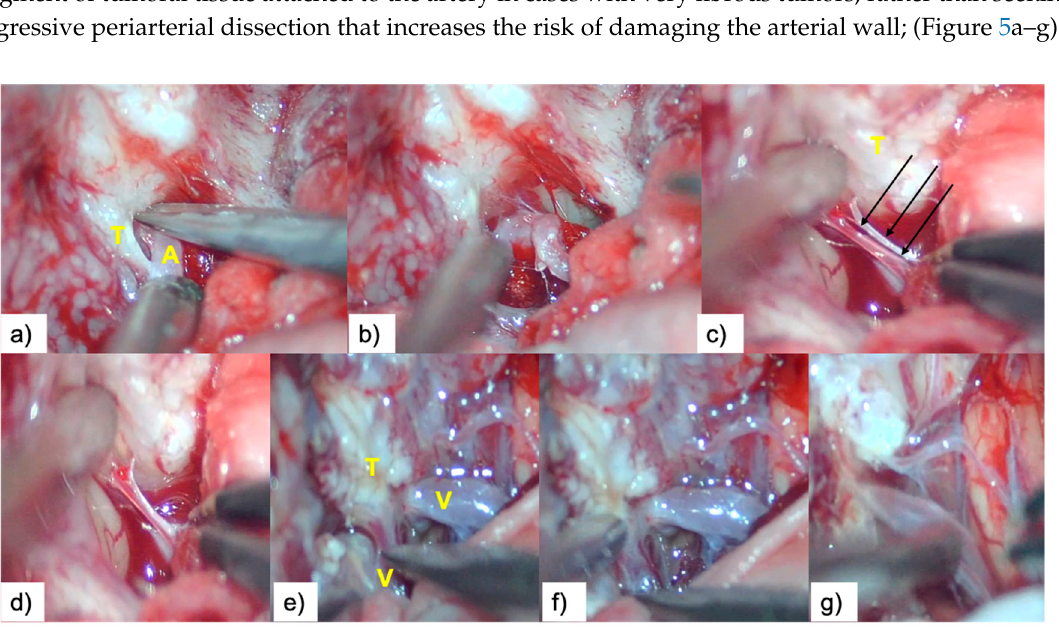
Figure 5. Vascular dissection: ( a , b ) arterial (A) dissection; ( c , d ) perforating arteries dissection (arrows); ( e – g ) venous (V) dissection. T = tumor.